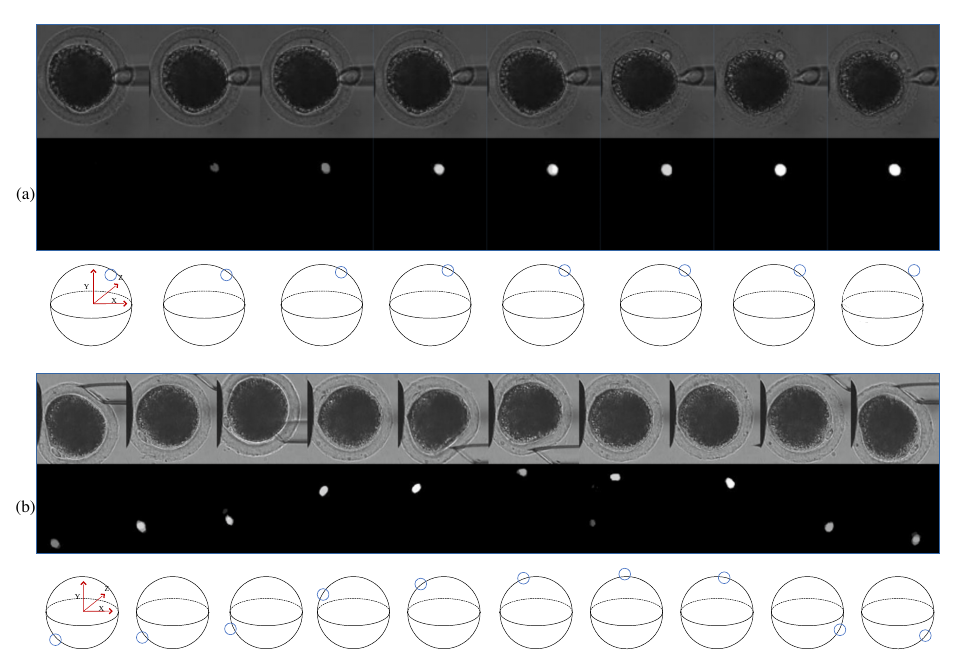
Figure 10. Detection result of two different oocytes during the rotation process. ( a ) Polar body from invisible to visible. ( b ) Polar body rotated around the cell